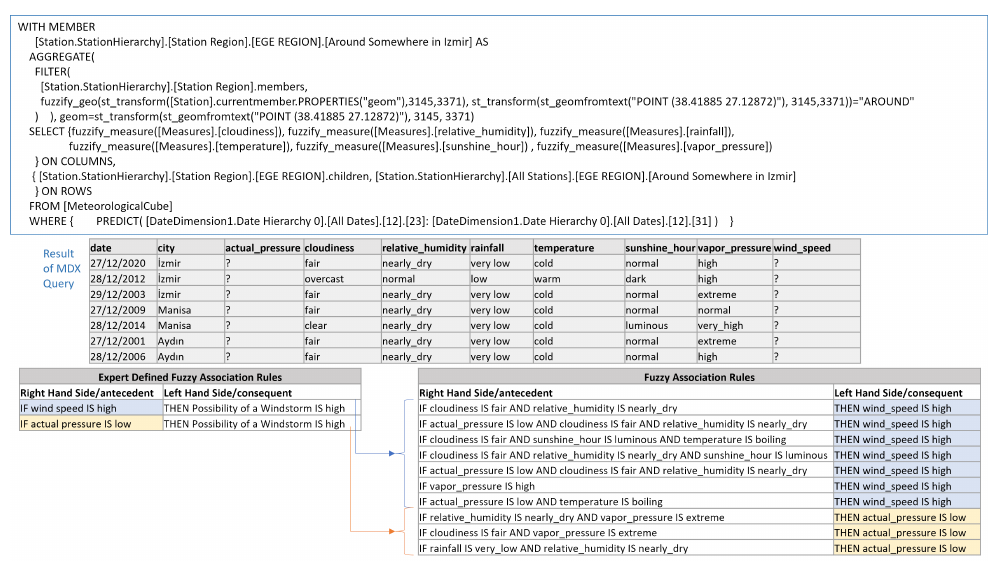
Figure 18. Fuzzy spatiotemporal predictive query execution: step